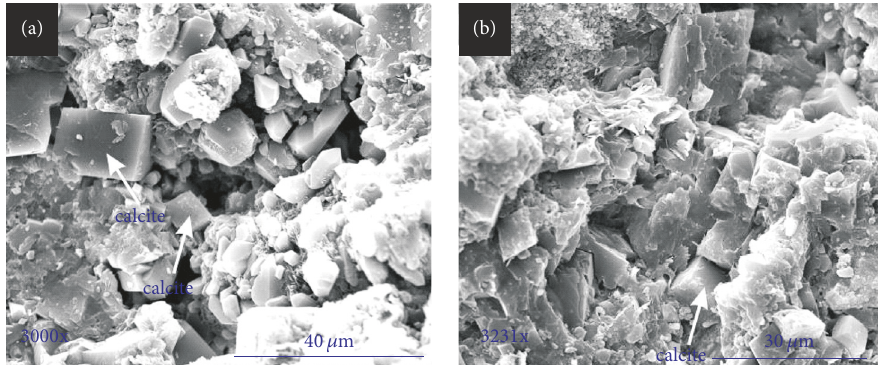
Figure 6: Scanning electron microscope of sandstone samples from the thick sand bodies in the Daqingzijing area. (a) Calcite cementation